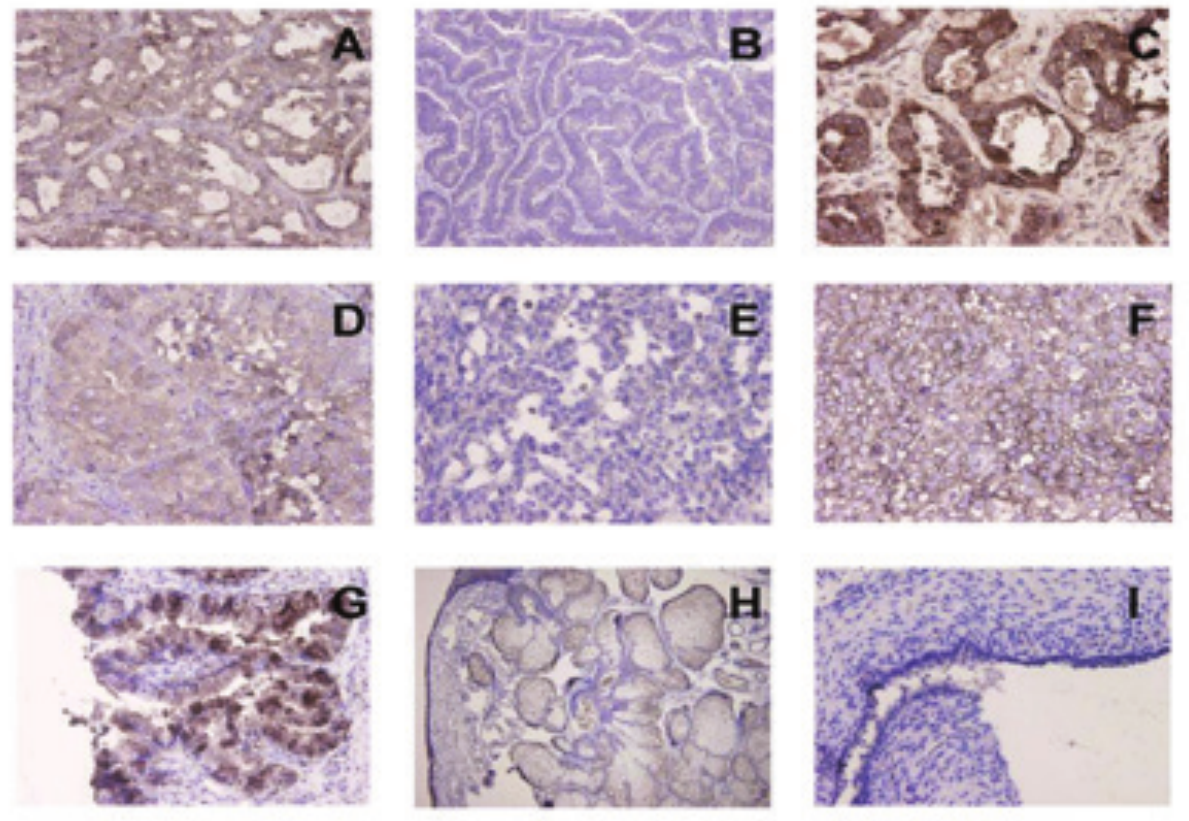
Figure 3: Expression of HE4 in ovarian tumor tissues Immunohistochemical staining of HE4 in serous ovarian cancer (Fig3A, ×400); mucous ovarian cancer (Fig3B, ×400); hyaline cell cancer (Fig3C, ×400); ovarian adenoendometrio carcinoma (Fig3D, ×400); corpus luteum cyst tumor (Fig3E, ×400); germ cell tumor (Fig3F, ×400); borderline ovarian tumor (Fig3G, ×400); ovarian benign tumor (Fig3H, ×400); ovarian endometriosis cyst (Fig 3I, and dysgerminomas was 100% (30/30), 66.67% (8/12), 66.7% (2/3), 100% (6/6), 25% (1/4) and 75% (3/4), respec- tively. The expression of HE4 expression in serous ovarian cancer was higher than that in mucous ovarian cancer, and the variance had the statistic meaning (χ 2 =11.437, P=0.003). HE4 was found to be modest or highly expressed in the ovarian endometrioid adenocarcinomas, clear-cell carcinomas and dysgerminomas, and lowly expressed in the yolk sac tumors. The rate of positivity HE4 expression in the tissue of the early stage ovarian malignant tumor (I/II stage) is 66.67%, which is lower than that of the later stage (III/IV stage, 97.22%) (χ 2 =10.787, P=0.001). In the highly differentiated tissues, the HE4 positive expres- sion rate was 37.50%, which was lower than that of the low differentiated tissue (92.00%, χ 2 =15.626, P<0.001). In the patients without metastasis, the positive expression rate was 35.57%, which was lower than that in the patient with metastasis (100%, χ 2 =32.318, P<0.001). Therefore, we believe that the serum level of HE4 was positively linked with the HE4 expression in the tissues (Table 3).